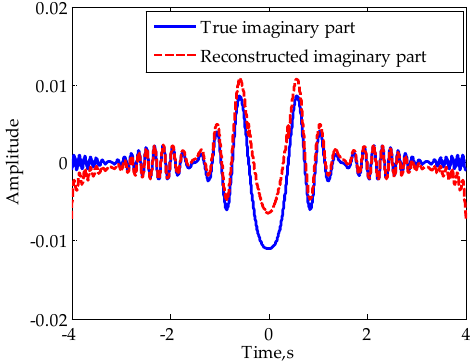
Figure 6. Reconstructed mainlobe RHS using the traditional method.